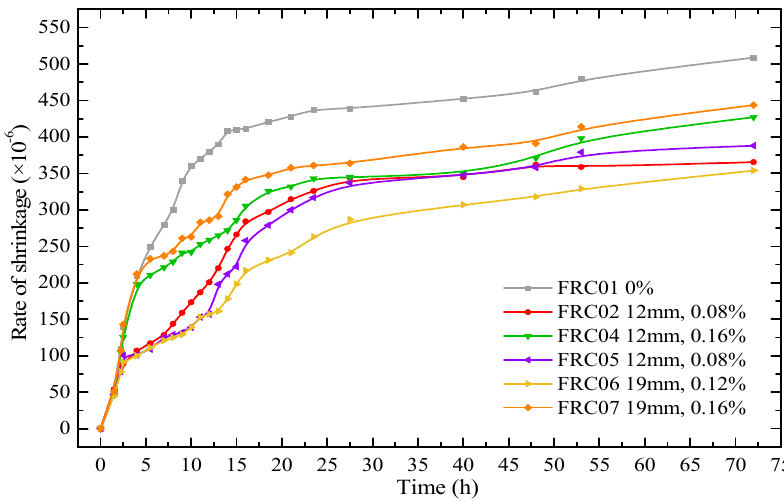
Figure 17. Free shrinkage deformation of prism concrete specimens during 72 h.